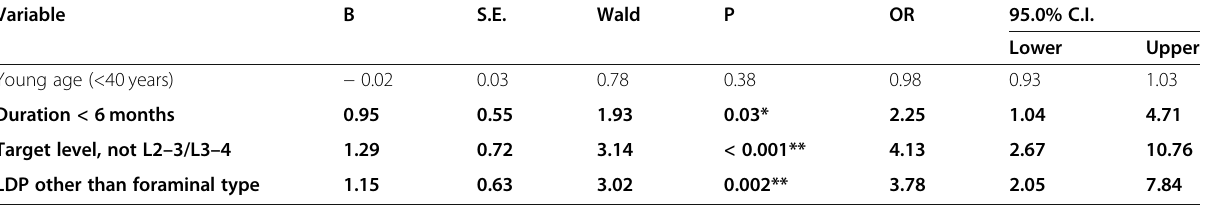
Table 7 Logistic regression analysis for significant predictors of successful procedure among the studied group